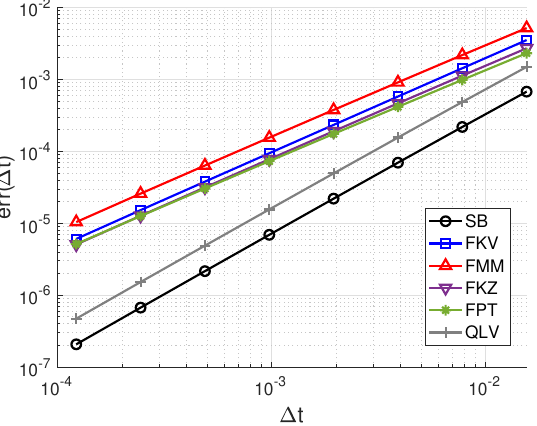
Figure 4. Convergence analysis for all fractional viscoelastic models with ( E 1 , E 2 , E 3 ) = ( 1,1,1 ) and ( β ) = ( 0.3,0.7,0.1 ) . A cubic strain function was employed with a reference solution using the 1 , β 2 , β 3 time step size ∆ t = 2 − 17 . A monotone loading test with the convergence rate of q ≈ 1.3 was applied for all